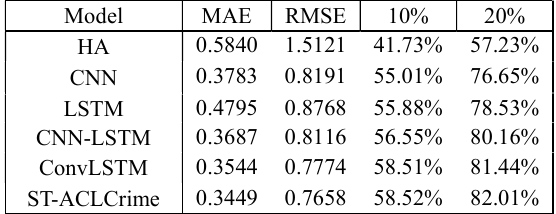
Table 2 . Comparisons the results of different models at 2000 meters spatial resolution.